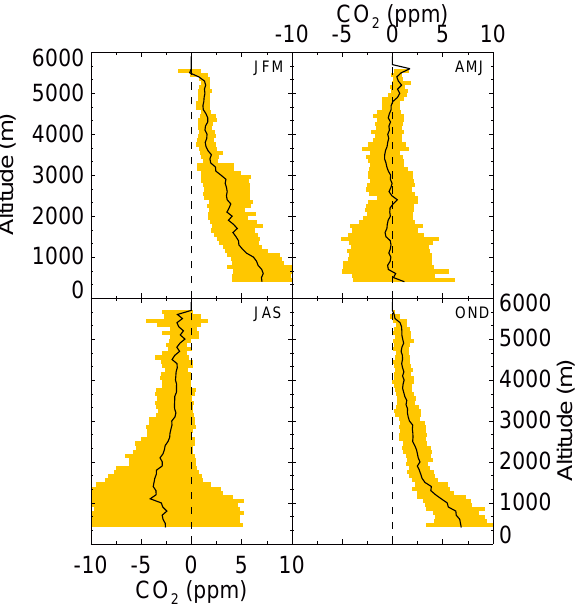
Fig. 11. Climatology of all vertical profiles collected between 2007 and 2010, shown as an anomaly relative to mole fraction at Mauna Loa (Mauna Loa data not yet available in 2011). CO 2 observations at the Mauna Loa observatory have been interpolated on a weekly basis to normalize flight profiles. CO 2 observations are binned into 100m altitude pixel and weekly flight profiles. Each quadrant of the graph corresponds to a 3-month average climatological vertical pro- file (JFM: January-February-March, ...). The solid black line shows the mean vertical profile calculated across each 3-month average, and the yellow shaded area shows one standard deviation around the average